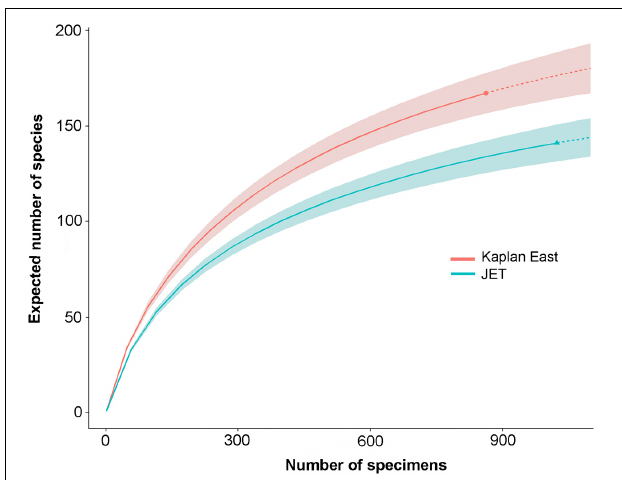
FIGURE 4 | Rarefaction curves with 95% confidence limits for foraminifera from the Kaplan East ( ∼ 15 ◦ N, 119 ◦ W; ∼ 4100 m depth) and JET (09 ◦ 14 (cid:48) N, 146 ◦ 15 (cid:48) W; 5300 m depth) sites. The curves are based on data from the 0-1 cm layer of subsamples (6.6 cm 2 surface area) of megacores, sieved on a 32- µ m screen (Nozawa, 2003,